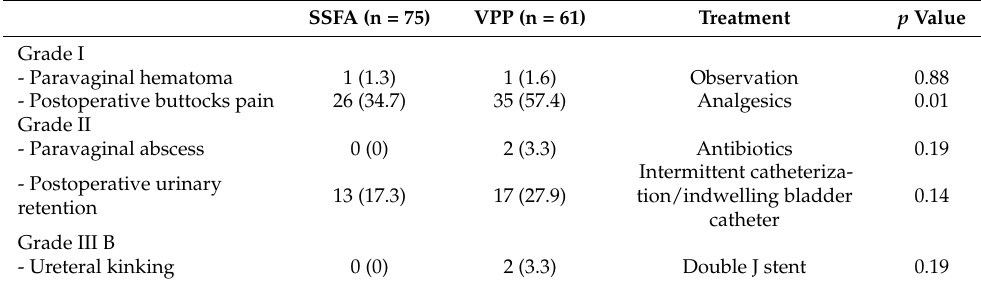
Table 6. Clavien–Dindo classification of peri- and postoperative complications.